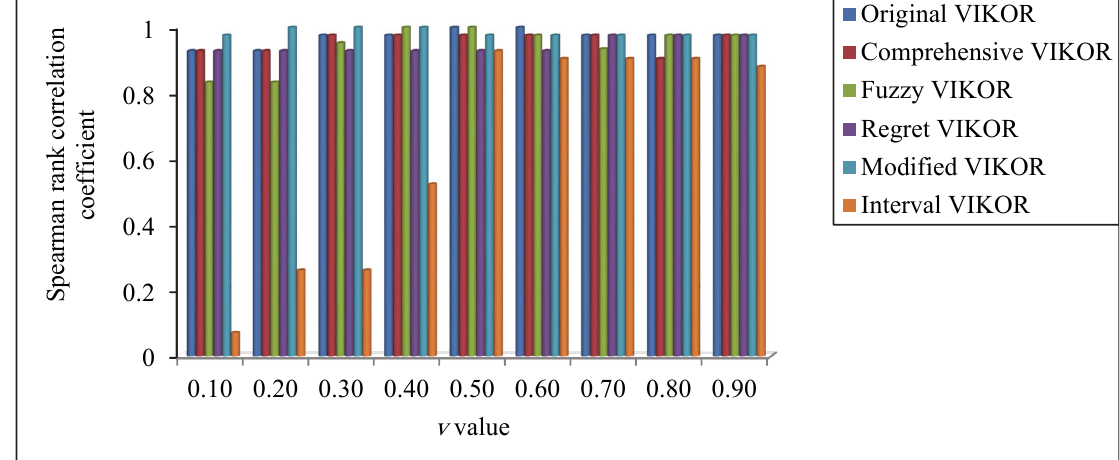
Fig. 1 Ranking performance of VIKOR method and its variants for changing v values in Example